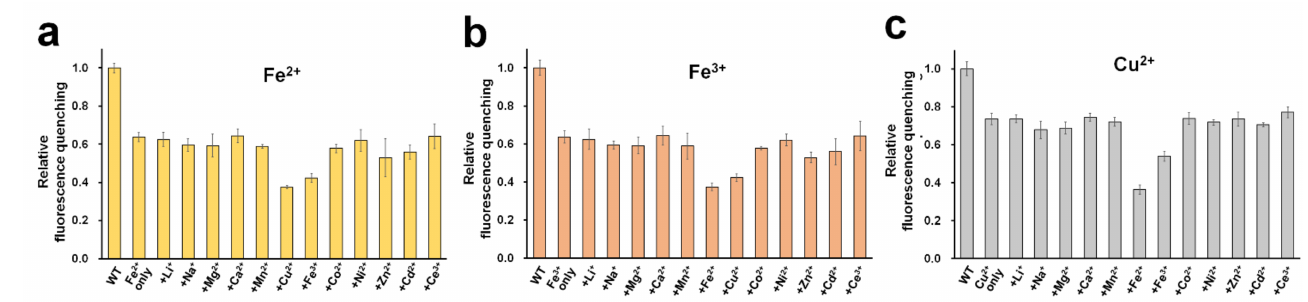
Figure 6. Selectivity. A mixture of ( a ) Fe 2+ , ( b ) Fe 3+ , or ( c ) Cu 2+ (25 µ M) and various metal ions (25 µ M) was incubated with DendFP solutions (4 µ M). For the control reaction, a solution containing only Fe 2+ , Fe 3+ , or Cu 2+ without interference metals was used. WT indicates a solution containing only DendFP. Data represent the means ± standard deviations of three